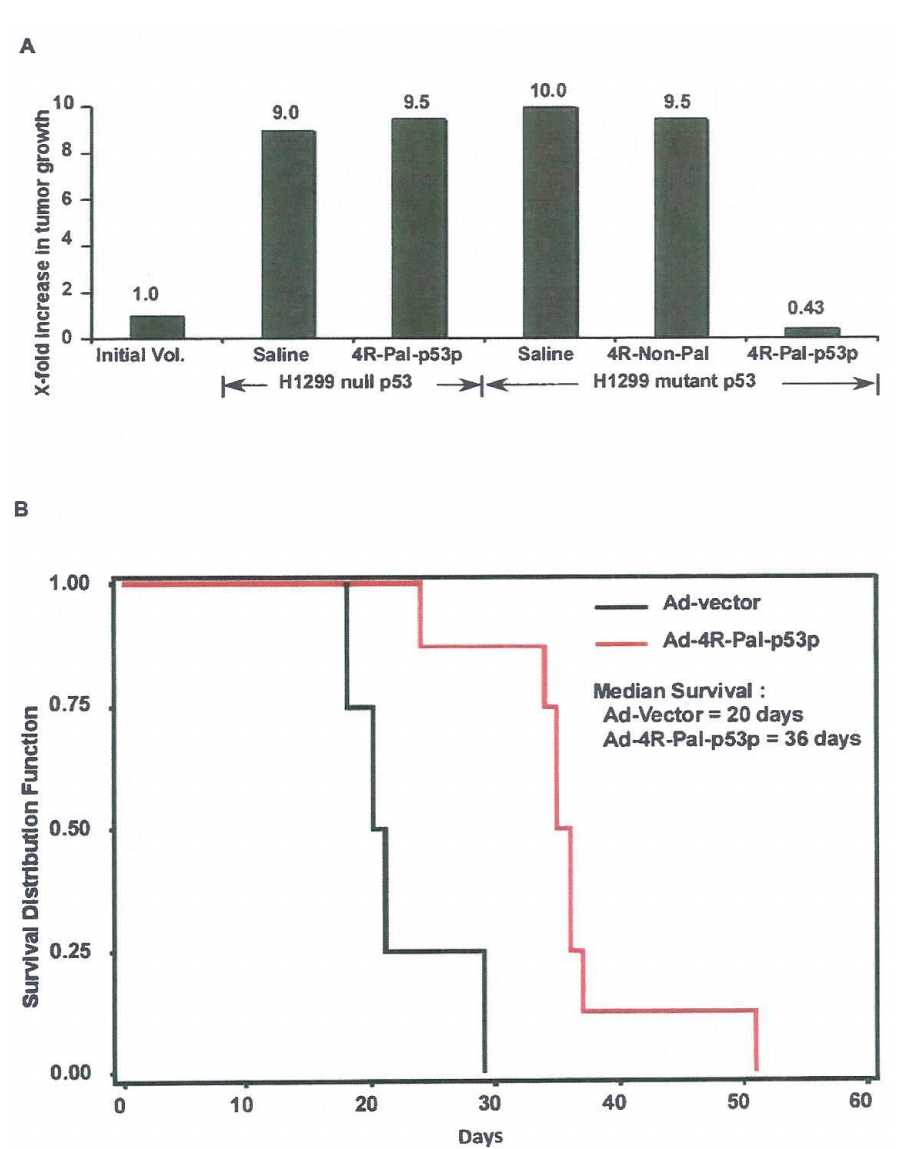
Figure 6. Animal studies. ( A ) The effect of Ad-4R-Pal-p53p-Ant on the growth of human lung cancer xenograft tumors. Human lung adenocarcinoma H1299 cells (null p53) and H1299 cells stably transfected with mutant p53 (R249S) were injected subcutaneously (1 × 10 6 cells) with Matrigel into the hind flank of female athymic (nude) mice age 8–10 weeks. After approximately 10 days, when the tumors became 100 mm 3 in size, osmotic Alzet pumps were surgically implanted juxtaposed to the tumors. The pumps delivered 100 µ L over a 14 day period of an adenovirus containing the 4R-Pal-p53p plasmid. The viral titer was 1 × 10 6 per µ L, so that 1 × 10 8 viral particles were delivered over 14 days. The volumes of the tumors were regularly monitored, and the results after 14 days of treatment are represented. Volumes were determined as the product of tumor W × L 2 ÷ 2. Student t -test analysis (n = 9/group) showed a p < 0.001 between palindromic tetrapeptide (0.43) and non-palindromic tetrapeptide control and saline treated groups (9.0–10.0). These numbers mean that in the H1299 p53 null group the tumor grew 9.0–9.5 fold higher than at the starting point (100 mm 2 ), irrespective of treatment and in the H1299 mutant p53 (R249S) group, and the saline and non-palindrome groups grew 9.5–10.0 fold larger than the starting point. However, in the tetrapeptide group, the tumors not only did not grow above starting point, but decreased 57% (end size =